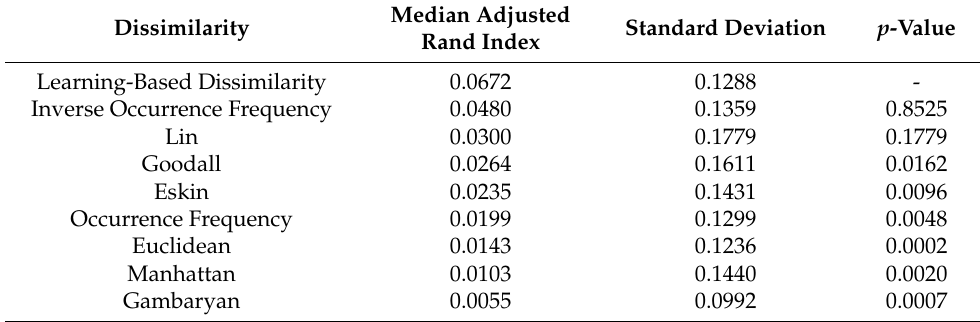
Table 6. Statistical results, according to Adjusted Rand Index [17], for KMeans++ [15] using all the dissimilarity measures, considering all the tested datasets. The last column corresponds to the p -value obtained when comparing our proposal (Learning-Based Dissimilarity) with the other dissimilarity measures using the Wilcoxon signed-rank test [22]. The results are sorted from top to bottom in descending order of the